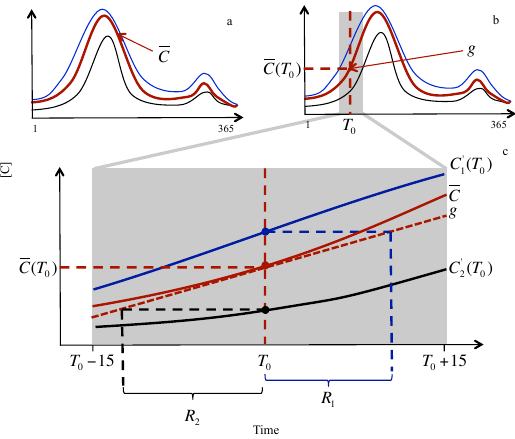
Figure 2. Calculation of the rate of change phenology anomaly for each location x,y , i.e. each 0 . 25 ◦ pixel ( R i (x,y) ). (a) Each sea- sonal cycle (solid black and blue lines) is used to estimate the cli- matology ( ¯ C(x,y,t) , dark red line). (b) The maximum increase g in ¯ C and the day on which it occurs ( T 0 ) are used as a reference to estimate how delayed or advanced surface bloom is each year. (c) A 30-day window around the T 0 is isolated for each year’s sea- sonal cycle. R i (x,y) is estimated from the difference between an- (T 0 ) , climatology ¯ C(T 0 ) , and g . The R i (x,y) is thus a value nual C (cid:48) i in days.